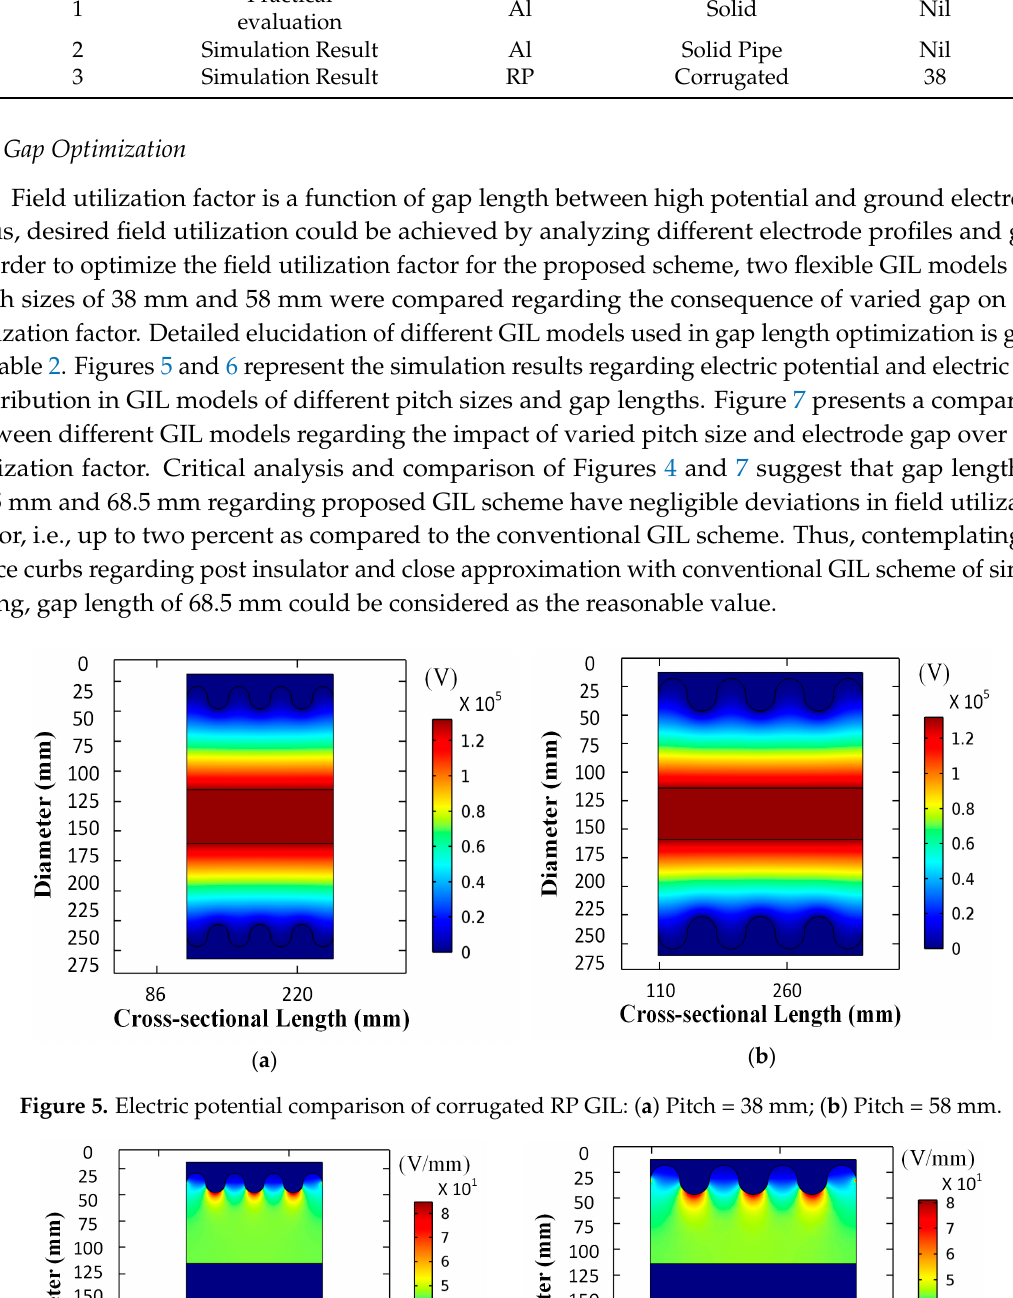
Table 1. Detailed specification of GIL specimens used for field utilization comparison.